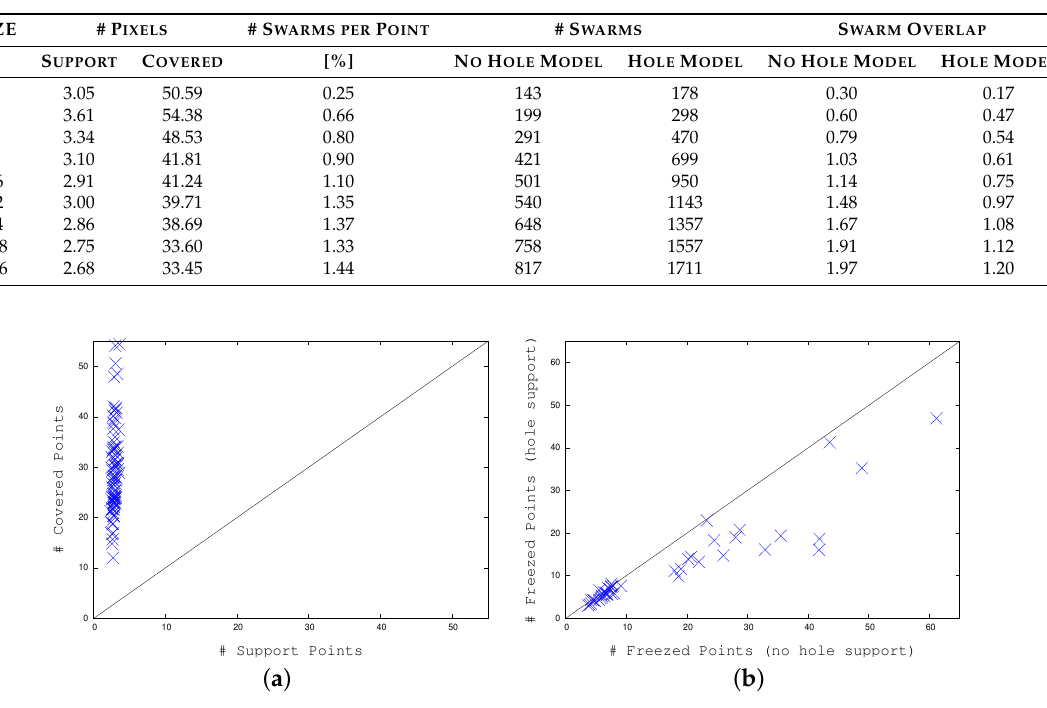
Table 3. Swarm statistics.